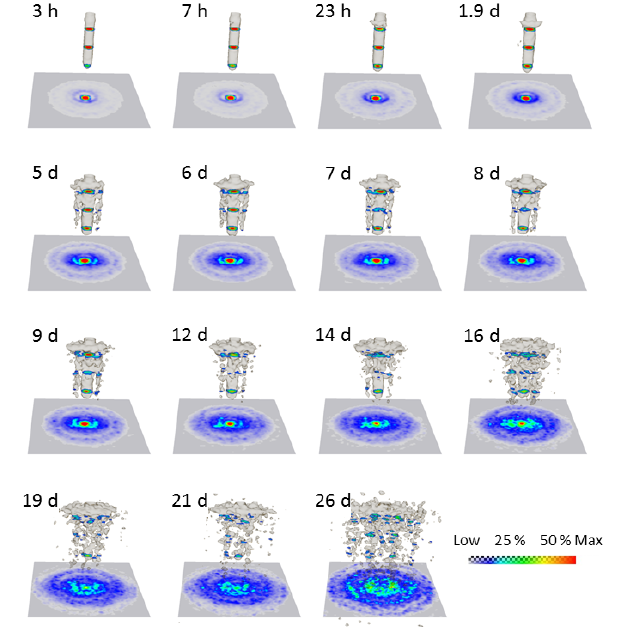
Figure 9. 15 PET frames of 123 I diffusion in an OPA drill core (diameter: 100mm, length 80mm). Each frame is depicted as iso- surface of the one-tenth maximum value (grey), three horizontal slices through the source region, and the axial (vertical) maximum projection at the bottom. The colour ranges are scaled frame-wise; the maximum value of the colour range is half maximum total am- plitude (for the corresponding amplitude distribution, see Fig.